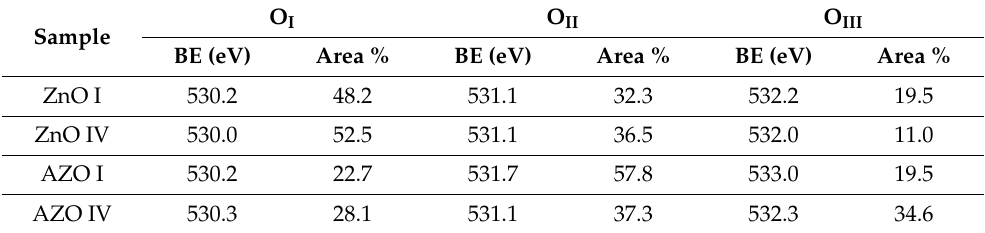
Table 4. Results of deconvolution of high-resolution spectra of O1s peak.